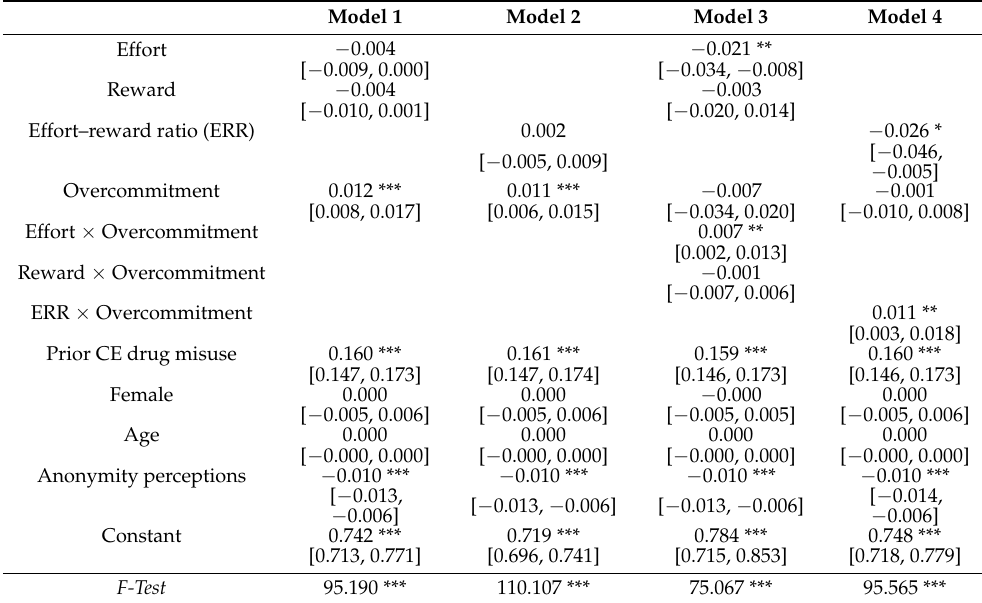
Table A1. Logarithmic 12-month misuse frequency of CE drugs (measured at t 2 ), based on ordinary least squares regression models—each model controls for anonymity perceptions ( N = 10,853 a ).